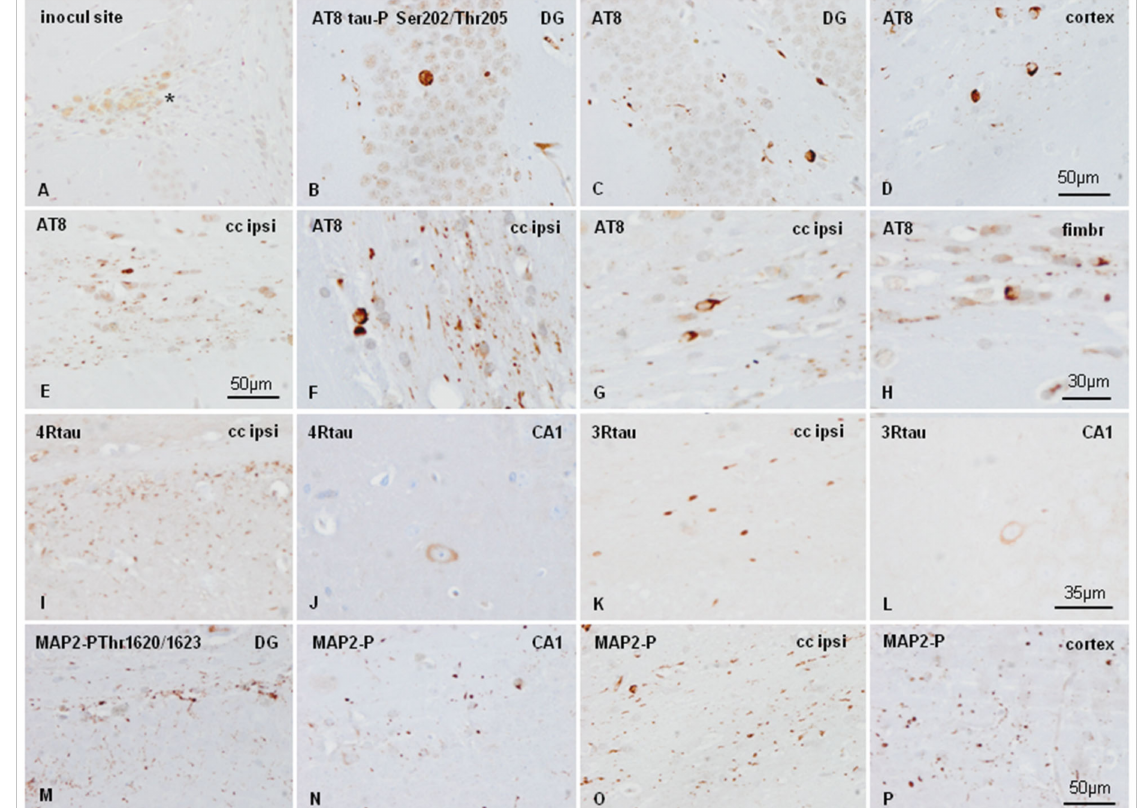
Figure 4. WT mice unilaterally inoculated into the hippocampus with AD sarkosyl-insoluble fractions at age six months and killed at the age of nine months showed a few macrophages filled with debris at the site of inoculation ( A ), and tau deposits in the CA1 region of the hippocampus ( CA1 ), dentate gyrus ( DG ), cerebral cortex (cortex), ipsilateral corpus callosum cc (ipsi), and fimbria (fimbr). Strong AT8 immunoreactivity is seen in neurons of the DG ( B , C ), and cortex near the site of inoculation ( D ), and in threads and glial cells in the corpus callosum ( E ). At higher magnification AT8-immunoreactive inclusions in glial cells in the corpus callosum and fimbria ( F – H ) are reminiscent of coiled bodies. Deposits of 4Rtau and 3Rtau are found in threads in the corpus callosum ( I and K , respectively), and in neurons of the CA1 region ( J and L , respectively). In addition to tau deposits, abnormal inclusions also recognized with anti-MAP2-P Thr1620/1623 antibodies ( M – P ). Paraffin sections slightly counterstained with hematoxylin, ( A – E ),( M – P ), bar = 50 µ m; ( F – H ), bar =30 µ m; ( J – L ), bar = 35 µ